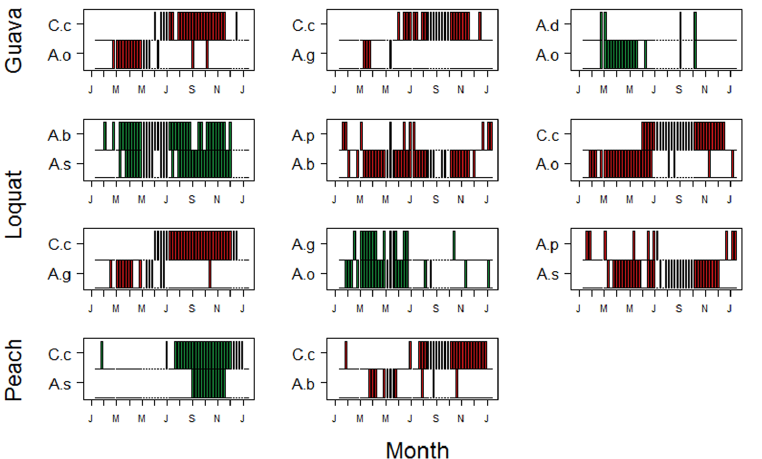
Fig 4. Co-occurrence pattern based on presence-absence data of significantly segregated (red panels) and aggregated (green panels) pairs of tephritid fruit flies sampled in 3 orchards in the year 2002. Each bar represents the presence of each species in a particular sample. Species abbreviations are: A. b. = A . bistrigata ; A.d. = A . distincta ; A.g. = A . grandis ; A.o. = A . obliqua ; A.p. = A . pseudoparallela ; A.s. = A . sororcula ; C.c. = C . capitata .